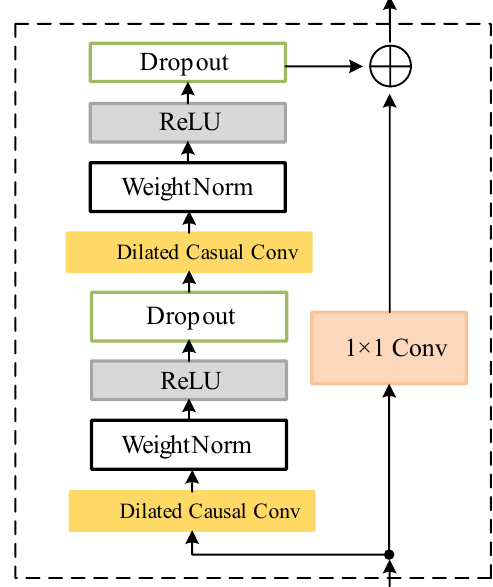
Figure 4. The structure of the TCN residual model.